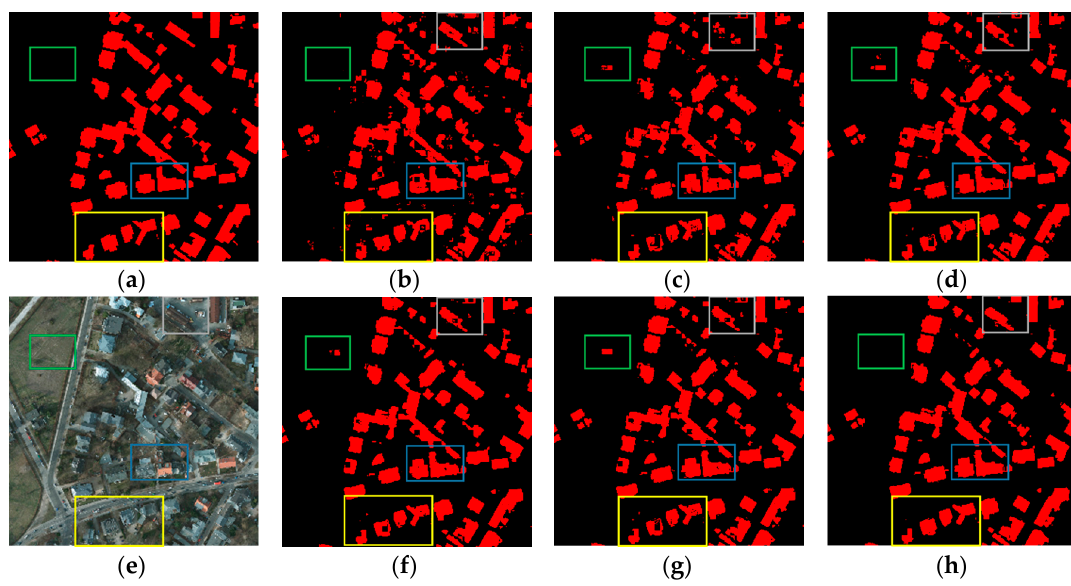
Figure 8. Predictions from different streams and the fused results using different decision-level fusion methods. ( a ) GT, ( b ) DSM prediction, ( c ) RGB prediction, ( d ) cross-modal prediction, ( e ) RGB image, ( f ) majority-voting, ( g ) averaging, and ( h ) Att-MFBlock. Table 5. Quantitative results of different decision-level fusion methods.